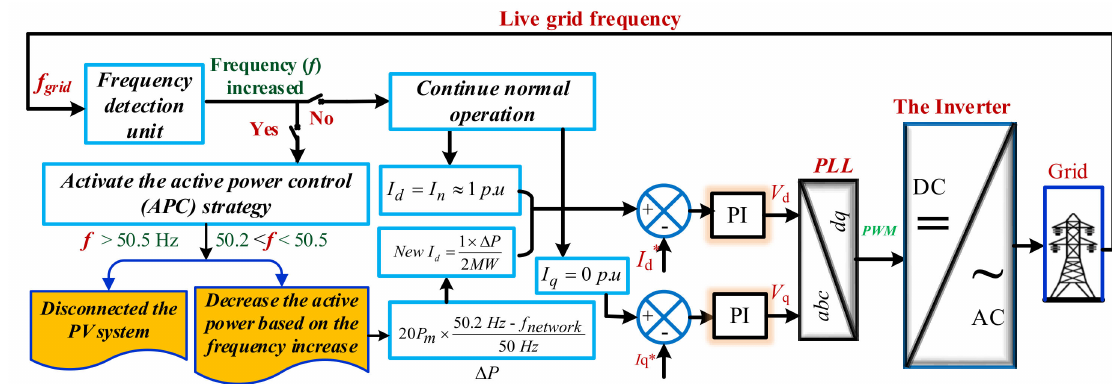
Figure 9. Controller structure of the APC-based grid-connected PV